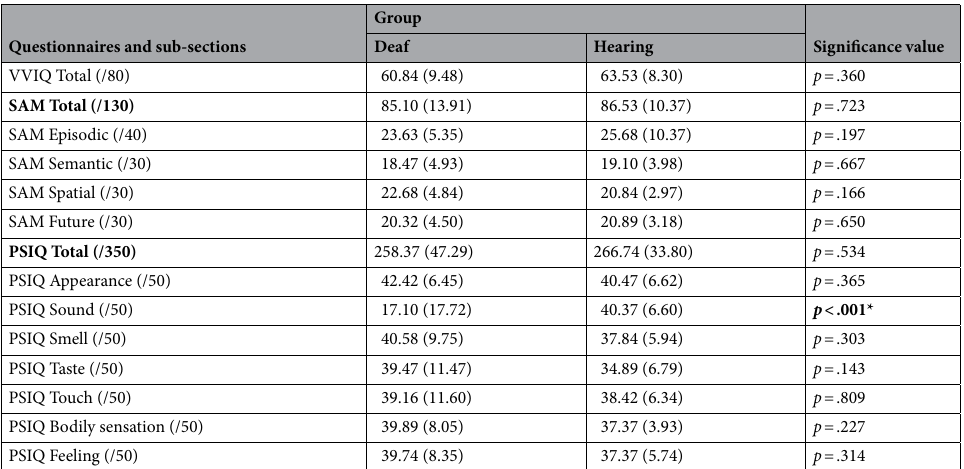
Table 1. Questionnaire data for participants in the deaf and hearing groups. Data are shown from the Vividness of Visual Imagery Questionnaire (VVIQ) (Marks 17 ), Survey of Autobiographical Memory (SAM) (Palombo et al. 18 ), and Plymouth Sensory Imagery Questionnaire (PSIQ) (Andrade et al. 19 ). Total scores and sub-scores for the SAM and PSIQ are shown. Data in parentheses show standard deviations. Independent t -test comparisons were used to probe possible between-group differences. Bold text shows p values that reached the threshold for significance. An accompanying asterisk (*) indicates that a significant p value remained following Bonferroni correction for multiple comparisons.